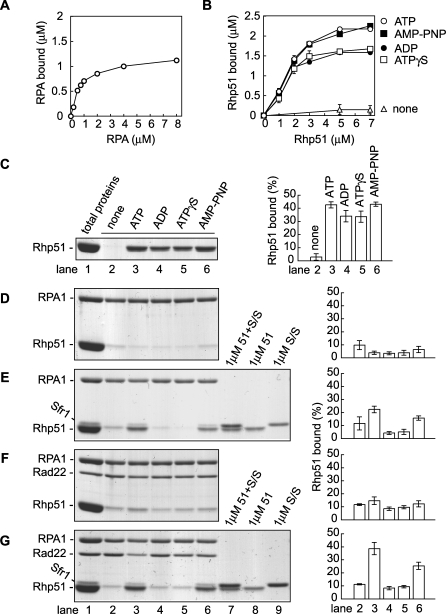
Pull-Down Assays Reveal That the Two Mediators Together Facilitate Rhp51 Presynaptic Filament Formation(A) A titration of RPA to css immobilized on magnetic beads. The indicated amounts of RPA were incubated with css beads (10 μM ssDNA) at 37 °C for 5 min. The protein–DNA complexes were pulled down, and RPA bound to ssDNA was analyzed by SDS-PAGE.(B) Titration of Rhp51 to css beads. The indicated amounts of Rhp51 were incubated with css beads (10 μM ssDNA) at 37 °C for 5 min in the absence or presence of various adenine nucleotides (2 mM). Rhp51-ssDNA complexes were pulled down, and Rhp51 bound to ssDNA was analyzed by SDS-PAGE. The values and error bars in the graphs in (A) and (B) are average percentages and s.d., respectively, obtained from three independent experiments.(C) Adenine nucleotide-dependent ssDNA binding of Rhp51. Rhp51 (5 μM) was pulled down with css beads (10 μM ssDNA) in the absence or presence of various adenine nucleotides (2 mM). The SDS-PAGE image shows bands corresponding to the Rhp51-ssDNA complex in the pull-down fractions.(D–G) RPA has a higher affinity than Rhp51 for ssDNA, and the two mediators synergistically promote Rhp51 presynaptic filament formation in an ATP-dependent manner. Mixtures, indicated below, were prepared and incubated with immobilized ssDNA. Pull-down complexes were analyzed by SDS-PAGE. (D) Rhp51 and RPA. (E) Rhp51, RPA, and Swi5-Sfr1. (F) Rhp51, RPA, and Rad22. (G) Rhp51, RPA, Swi5-Sfr1, and Rad22. The concentrations of proteins used in all assays were 5 μM Rhp51, 1 μM RPA, 0.5 μM Swi5-Sfr1, and 0.5 μM Rad22. A quantitation of bound Rhp51, calculated as a percentage of the amount of Rhp51 in each lane 1 (100%), is shown at right. The values and error bars in the graphs are average percentages and s.d., respectively, obtained from three independent experiments. (C–G) lane 1: input proteins, lane 2: no nucleotide, lane 3: ATP, lane 4: ADP, lane 5: ATPγS, and lane 6: AMP-PNP. Lanes 7, 8, and 9 in (E) and (G) contain Rhp51 (1μM) plus Swi5-Sfr1 (1μM), Rhp51 (1μM) alone, and Swi5-Sfr1 (1μM) alone, respectively, for standards of relative migrations of these proteins.